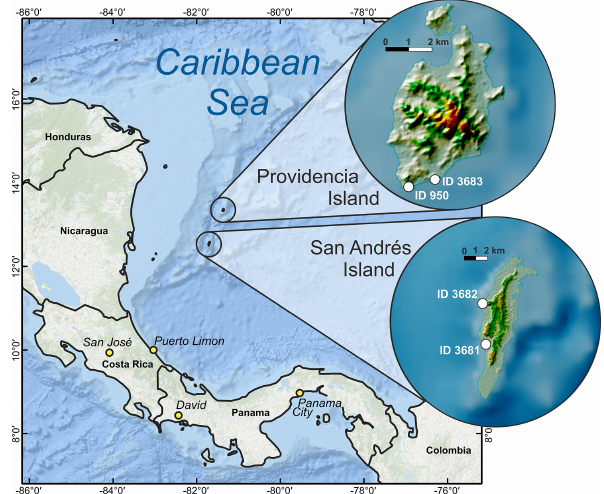
Figure 9. Location of Providencia and San Andrés islands within the Caribbean Sea. The insets show last interglacial sea-level data on the two islands. Basemap: Esri, Garmin, GEBCO, NOAA NGDC (now NCEI), SRTM 30m by NASA EOSDIS Land Pro- cesses Distributed Active Archive Center (LP DAAC, https://